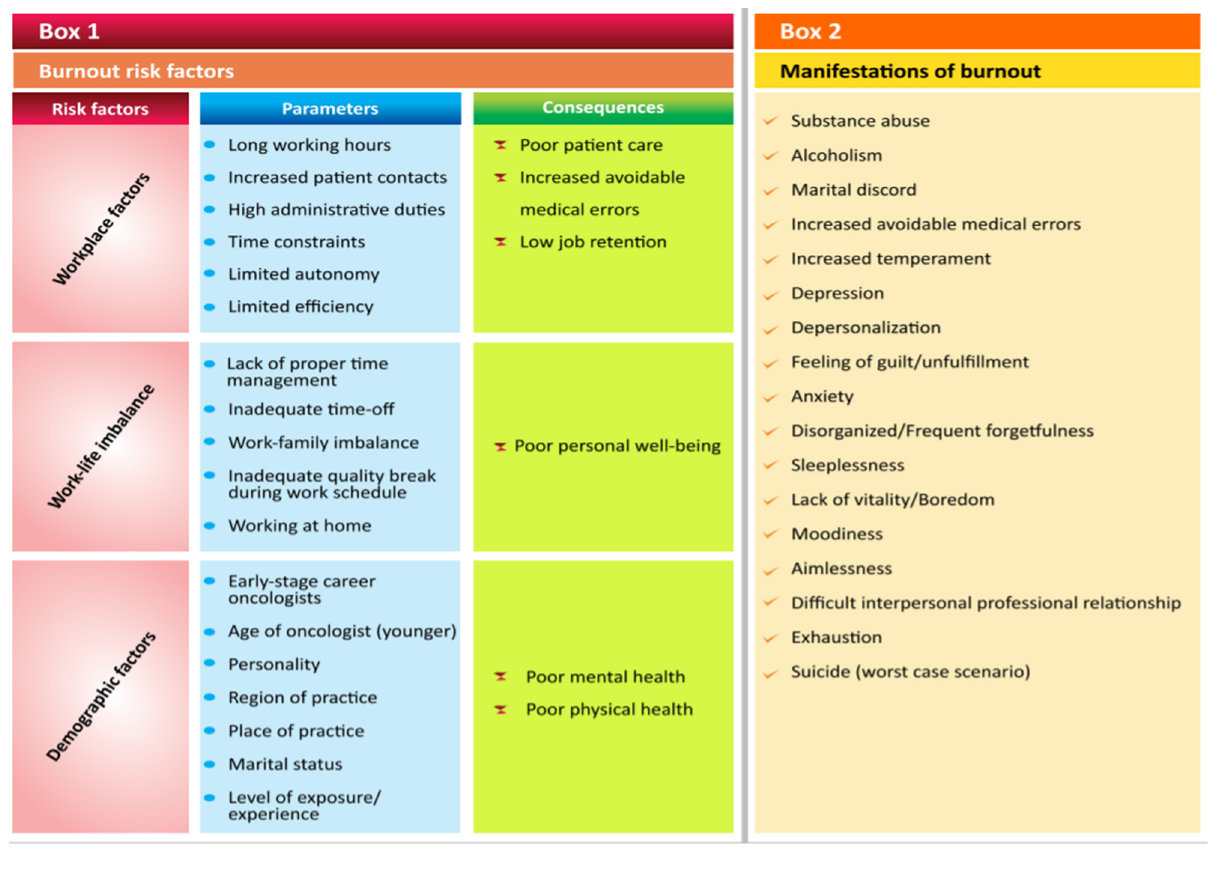
FIGURE 2 | The prevalence, expression, and manifestations of burnout in the oncological